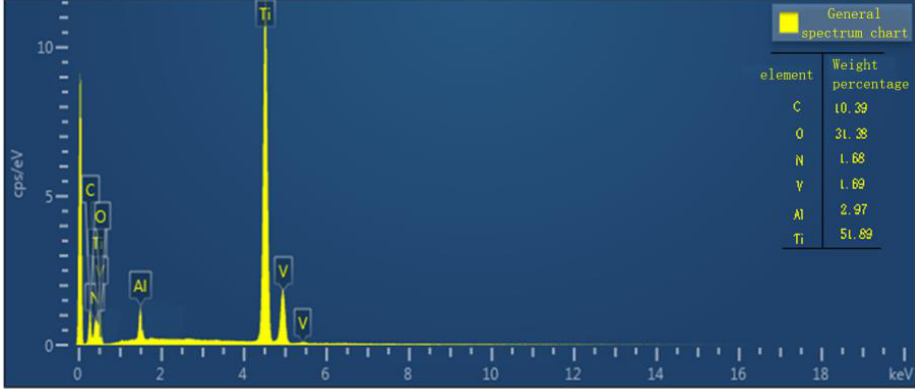
Figure 17. Surface composition of the workpiece after laser